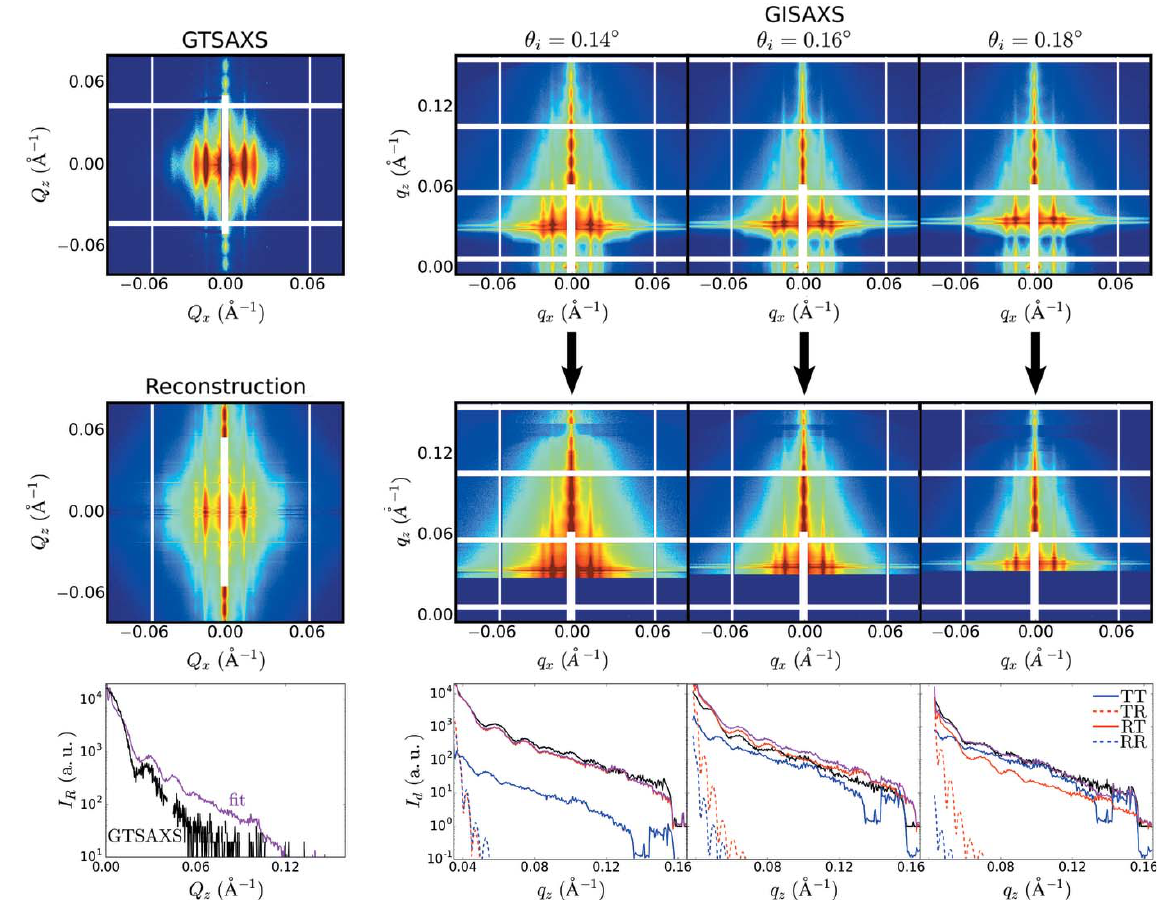
Figure 6 Example reconstruction of true (SAXS) scattering data based on combined fitting of multiple experimental GISAXS images. The corresponding experimental GTSAXS data are presented as an alternative estimate for the true SAXS scattering pattern (upper left). The upper row shows the experimental GISAXS images (at multiple incident angles), while the middle row shows the corresponding GISAXS fits obtained from reconstruction. The bottom row shows example one-dimensional linecuts through the data (at q x = 0.0138 A˚ (cid:3) 1 ). The experimental data are shown in black, the reconstruction/fit is shown in purple and the individual DWBA components are shown in blue or red. The direct comparison between the reconstruction and the GTSAXS data (bottom left) demonstrates that the GISAXS reconstruction is robust and has a higher SNR (GTSAXS curve, black, was offset vertically to aid in